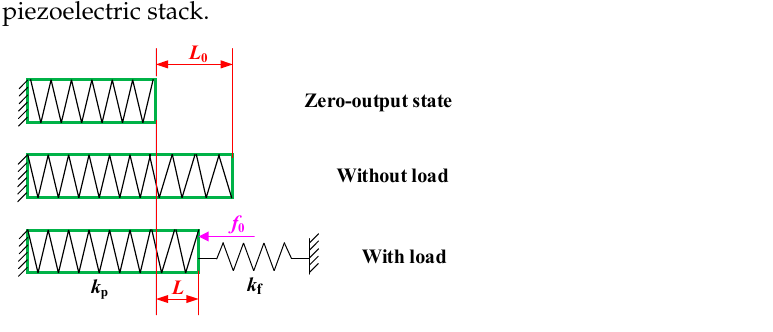
Figure 8. Several states of piezoelectric stack [38].